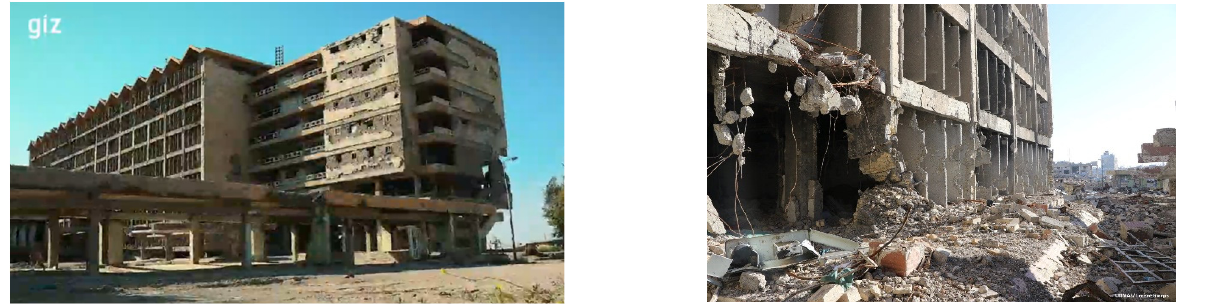
Figure 3. Al ‘Salaam hospital in Mosul after the Islamic State (IS) era [27].